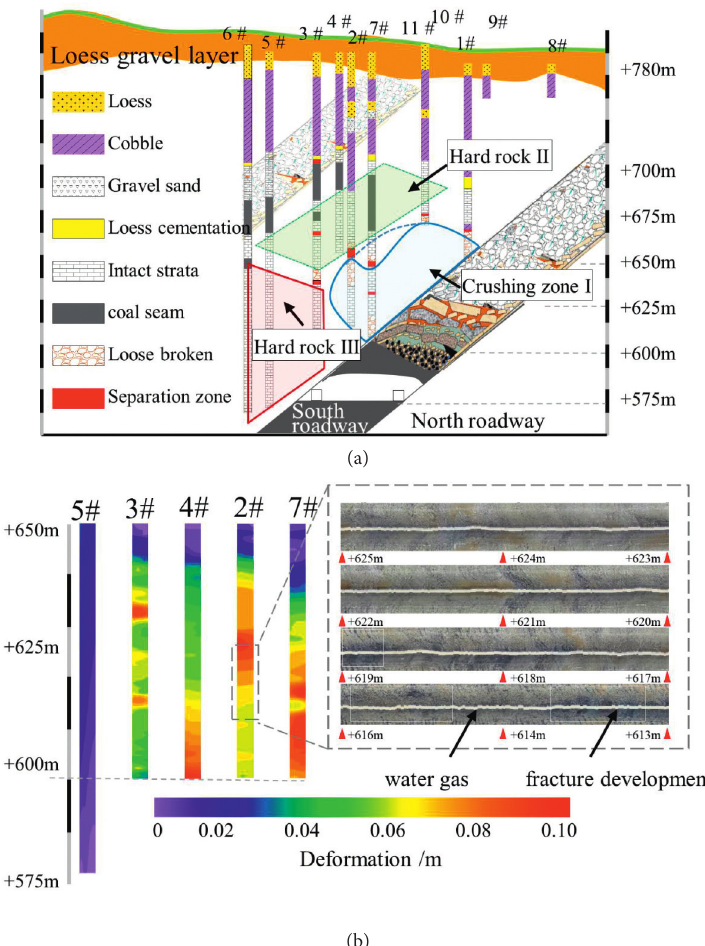
Figure 8: Fracture distribution and evolution diagram of coal and rock mass: (a) overburden structure visualization; (b) fracture evolution of coal and rock